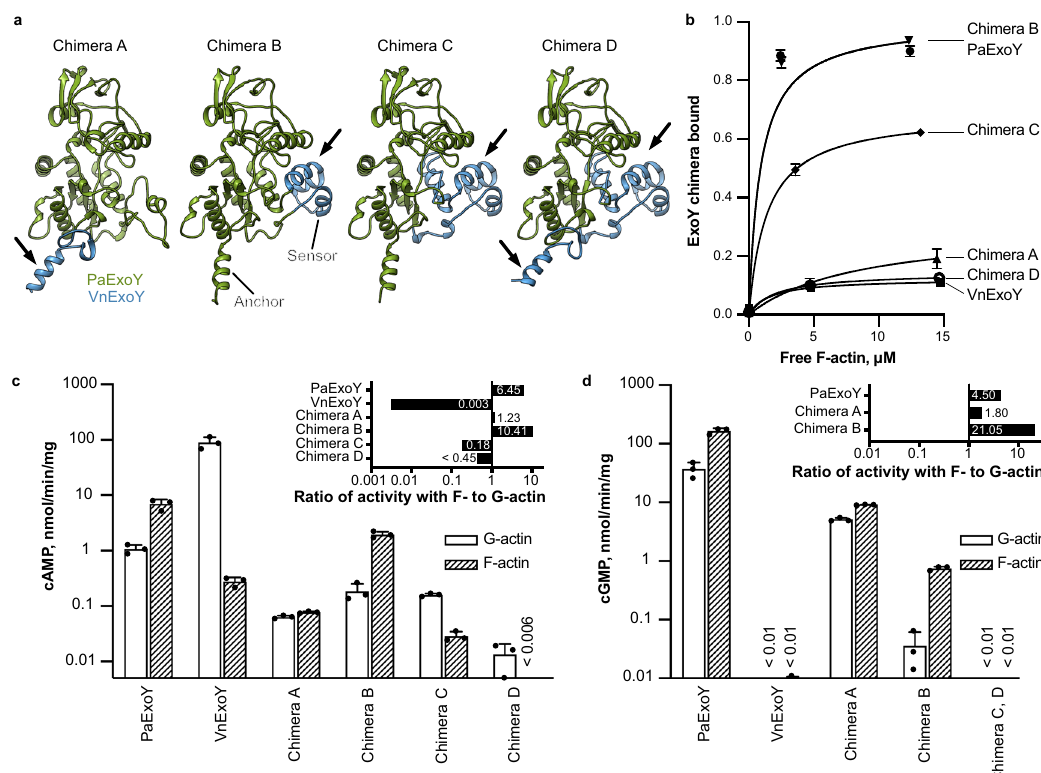
Fig. 4 Chimera proteins of PaExoY and VnExoY. a Models of chimera proteins, where regions of PaExoY (green) were swapped (arrows) with the corresponding parts of VnExoY (light blue) obtained by homology modeling. b Cosedimentations of F-actin with 2.5 μ M of PaExoY, VnExoY or the chimera proteins quanti fi ed by densitometry. c Adenylyl and d Guanylyl cyclase activity of nucleotidyl cyclases in the presence of 2 μ M latrunculin-stabilized G- or phalloidin-stabilized F-actin, measured during 60 min of incubation. All other chimera proteins created in this study are presented in Supplementary Fig. 8 and Supplementary Table 3. The data in b – d , are presented as mean values, the error bars correspond to standard deviations of three independent experiments. Individual data points are available in Source